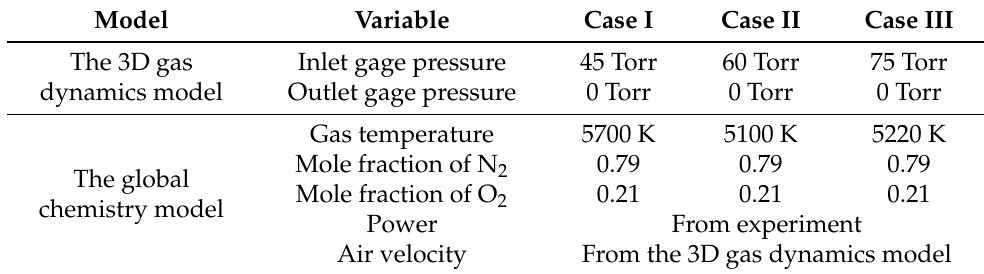
Figure 7. The voltage–current profile ( a ) measured by an oscilloscope and the evolution photographs of the gliding arc ( b ) captured by a high–speed camera in our experiment with the pressure difference of 45 Torr. Table 2. Initial conditions of the coupled 3D–0D